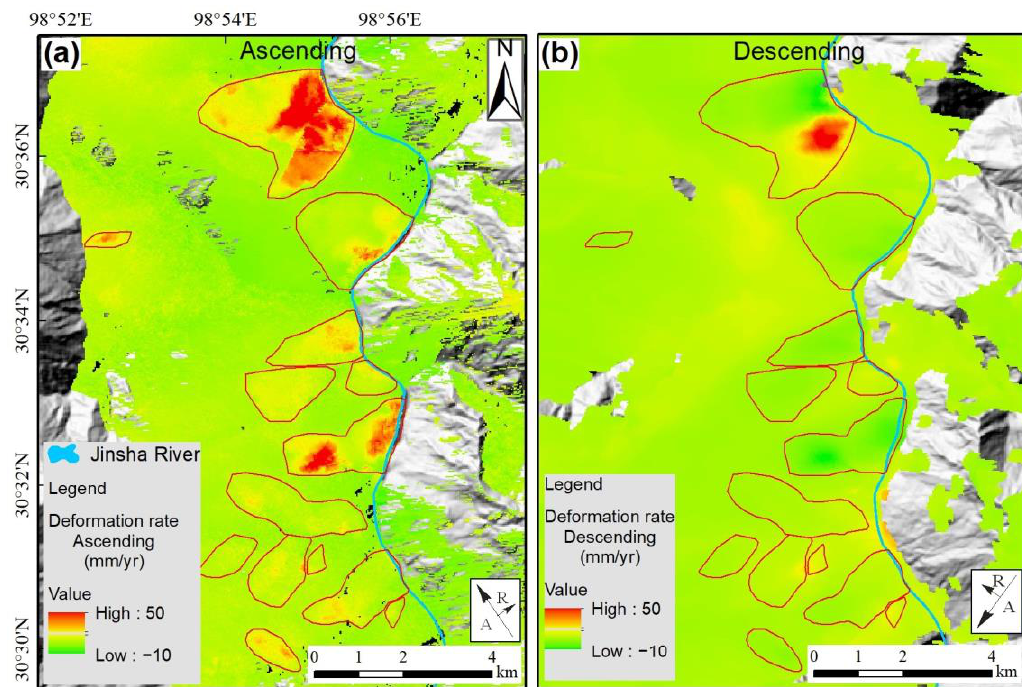
Figure 15. Comparison of deformation results in the ascending and descending measurement directions. (a) LOS deformation acquired from Sentinel-1 ascending images; (b) LOS deformation acquired from Sentinel-1 descending images.